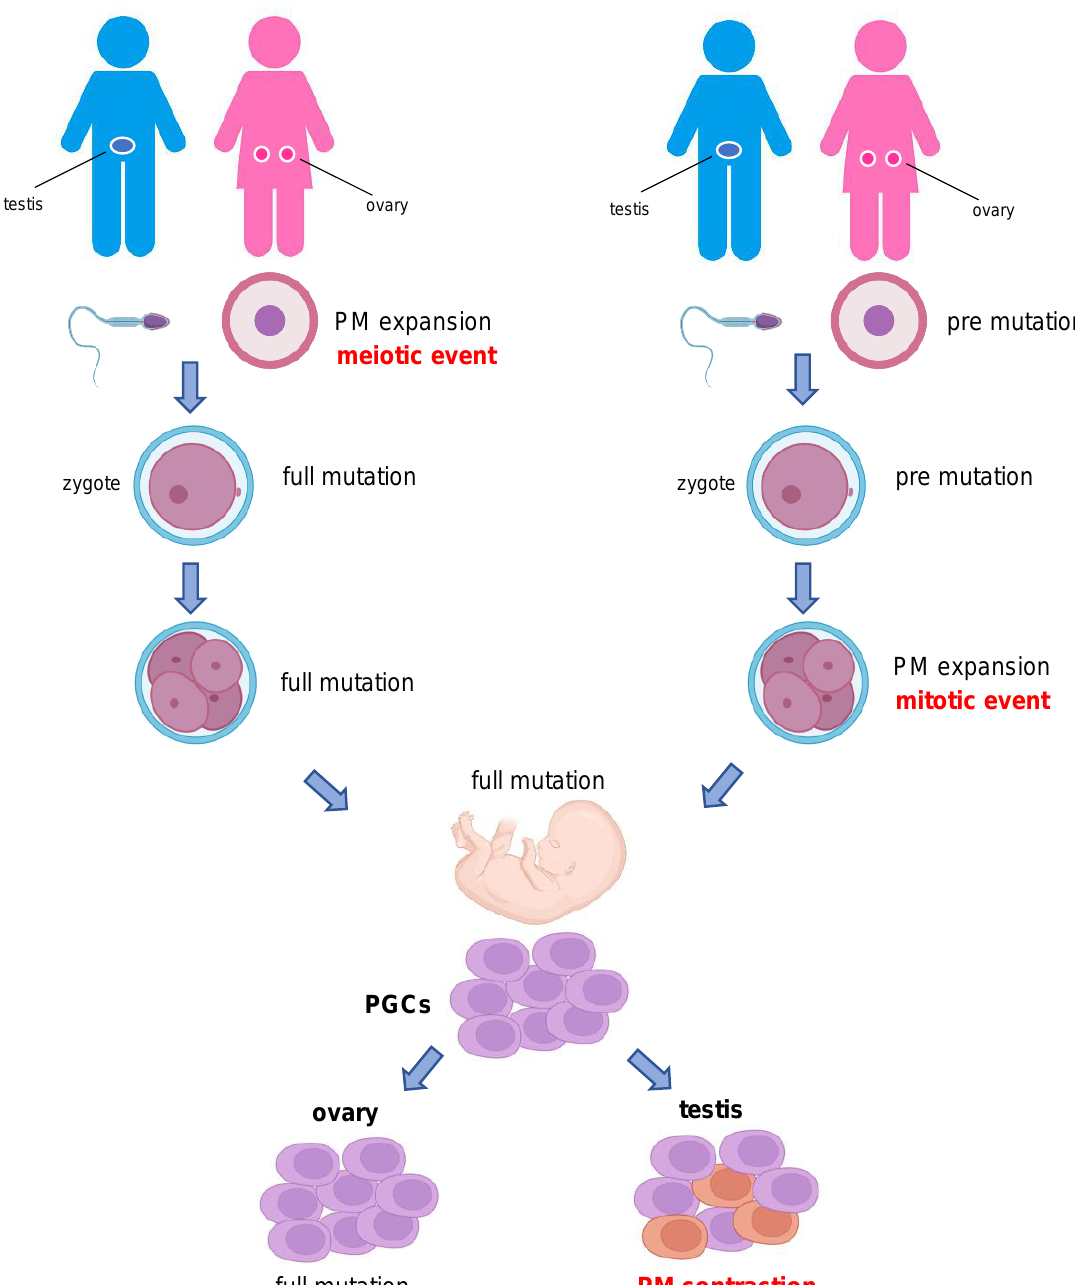
Figure 1. Two models to explain PM-to-FM expansion. The prezygotic model speculates that PM would jump to FM only during maternal germline (meiosis), possibly during recombination, and would further expand during early embryo development (on the left). The postzygotic model hypothesizes that an oocyte carrying a PM would expand to FM during the very first stages of embryogenesis (mitosis) before primordial germ cell (PGC) segregation (on the right). This model does not readily explain why a PM allele transmitted by a father to his daughters cannot expand to FM.